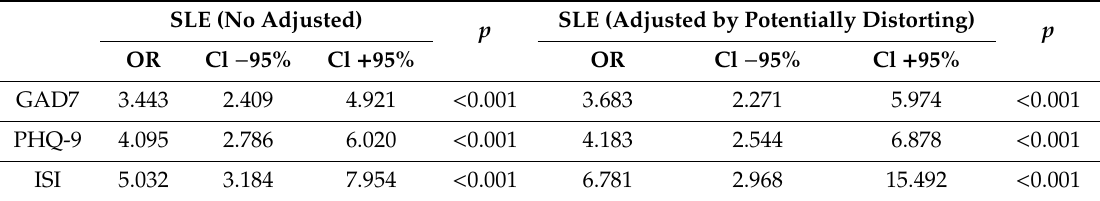
Table 3. Logistic regression model of the severity of mental health disorders in patients with and without systemic lupus